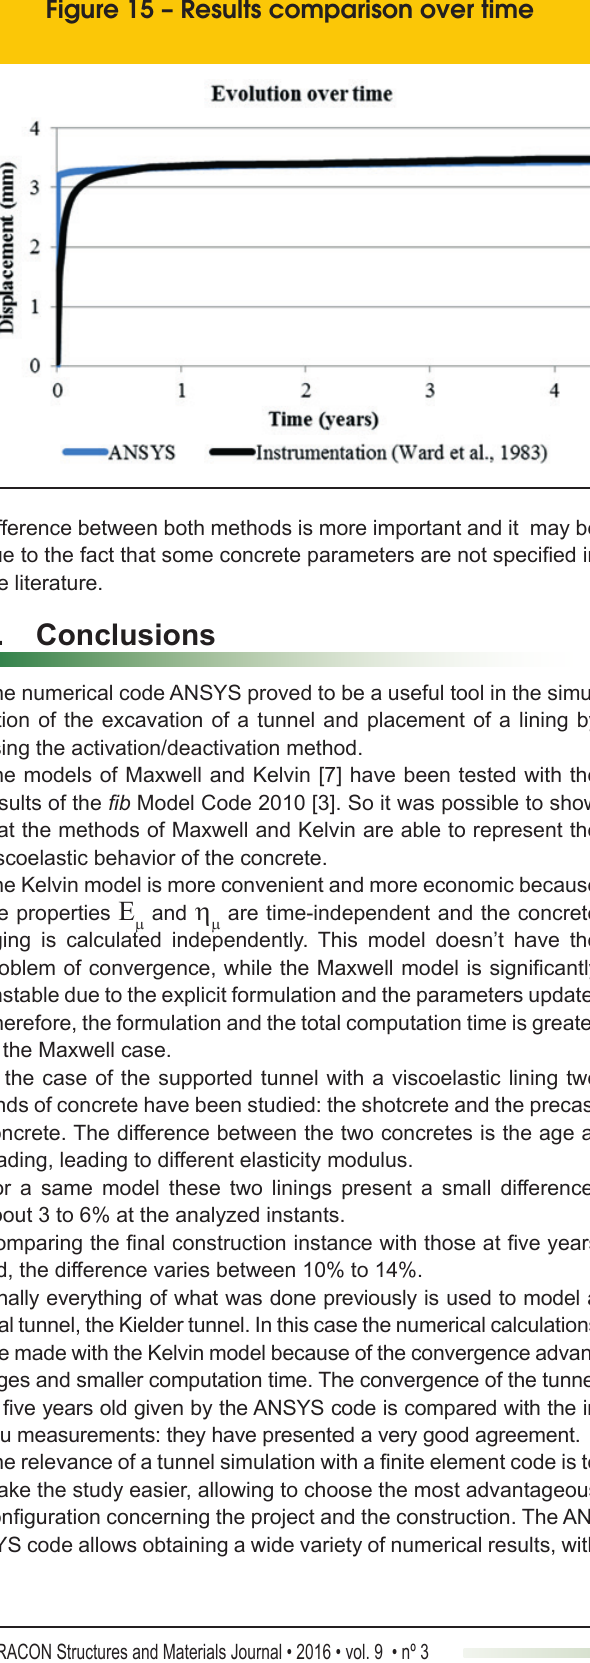
Figure 15 – Results comparison over